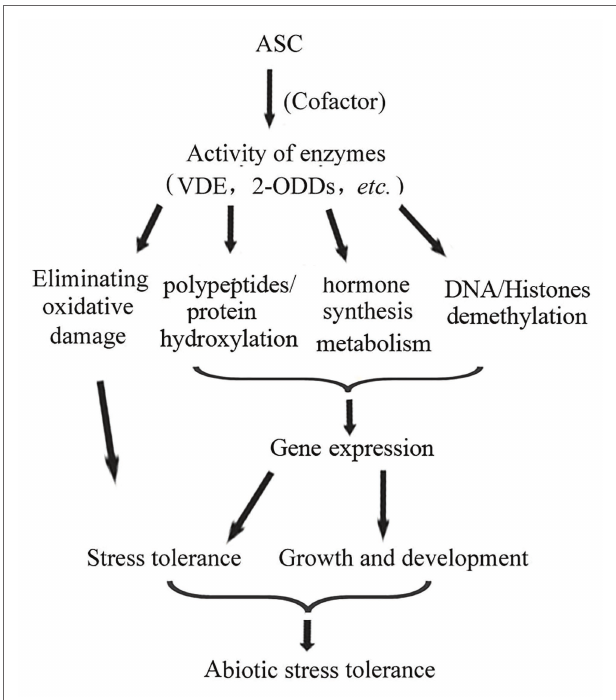
FIGURE 2 | As a cofactor of various oxidases, ASC regulates plant growth and development and abiotic stress responses, enhancing plant abiotic stress tolerance, via multiple